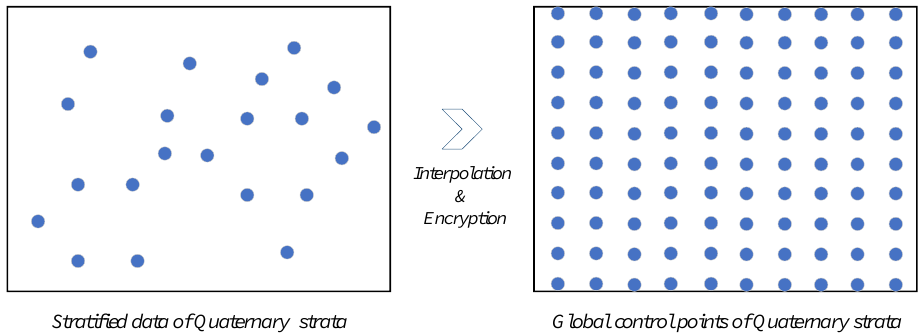
Figure 1. Technical scheme for the interpolation and encryption of Quaternary stratum.